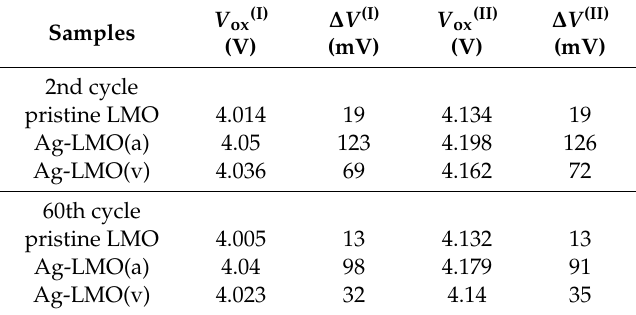
Figure 12. Incremental capacity ( − d Q / d V vs. V ) curves at the 2nd and 60th cycles extracted from data of galvanostatic measurements carried out at 0.1C rate for: ( a ) pristine LMO; ( b ) Ag / LMO(a); and ( c ) Ag / LMO(v) electrodes. Table 5. Results of the differential capacity analysis. The potential difference Δ V = V ox − V red is given for the phases I and II.